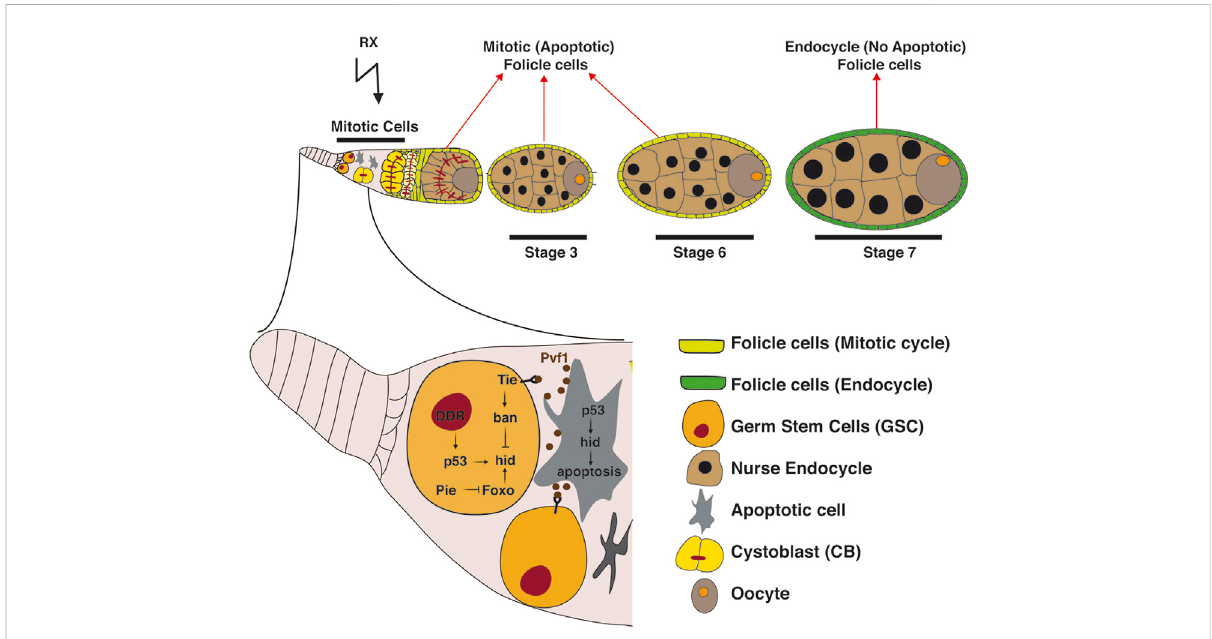
FIGURE 3 A schematic representation showing the germarium of the Drosophila ovary. Proposed mechanism of how female GSCs are protected against apoptosis through the collaborative contribution of multiple signalling pathways. Dying cells send Pvf1 as a survival signal that activates the Tie receptor in GSCs. Tie activation leads to ban microRNA upregulation that represses Foxo and p53 mediated hid activation in response to DNA damage. Created with